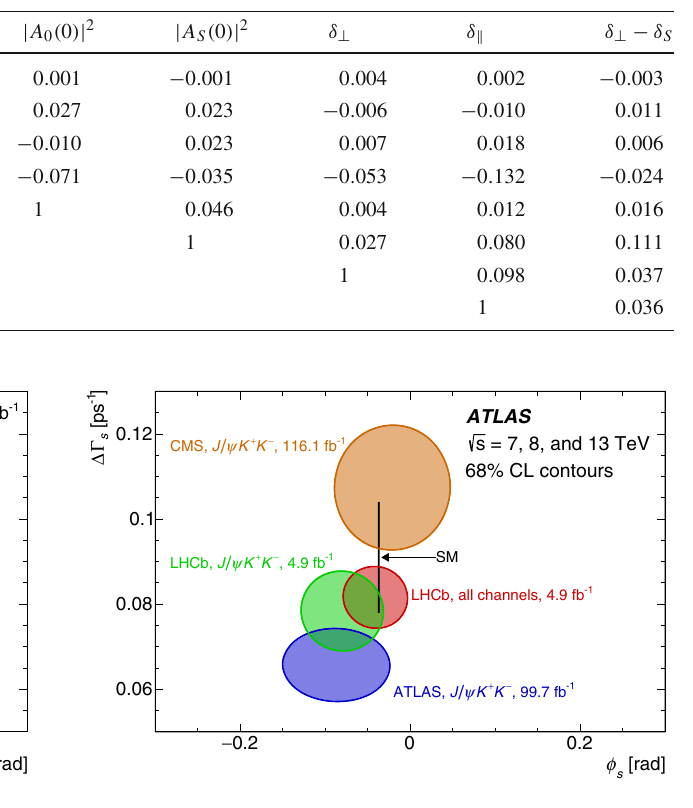
Fig. 12 Contours of 68% confidence level in the φ s – (cid:5)(cid:6) s plane, including results from CMS (orange) and LHCb (green) using the B 0 s → J /ψ K + K − decay only and LHCb (red) for all the channels. The blue contour shows the ATLAS result for 13 TeV combined with 7 and 8 TeV. The Standard Model prediction [5,52] is shown as a very thin black rectangle. In all contours the statistical and systematic uncer- tainties are combined in